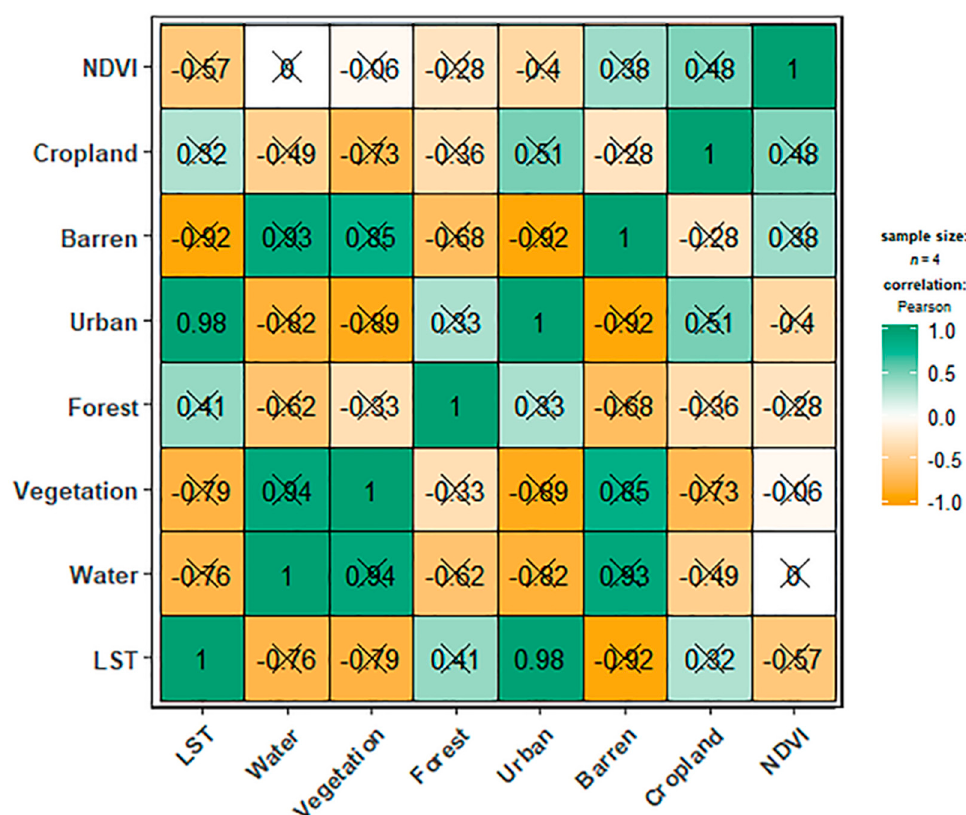
Figure 7. Correlation matrix of variables. Every correlation coefficient that matches two variables was calculated with the Pearson correlation method in R. Numbers ranging from − 1 to 1 are Pearson’s rank correlation coefficients (r) of variables on horizontal and vertical axes. Color depth indicates the correlation strength, while numbers show the R-values and X represents the non-significance correlation between the variables at p < 0.05.